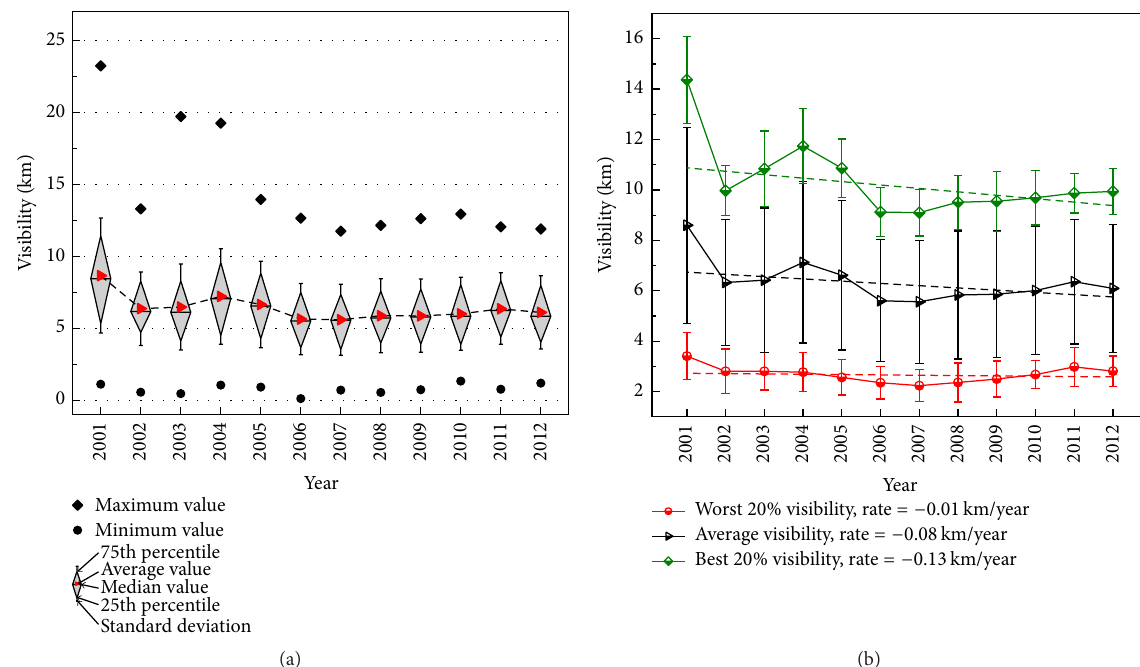
Figure 5: (a) Statistical box chart of long-term trends for the visibility in Hefei during the period from 2001 to 2012. The range of the box represents the interquartile range of the data. (b) The worst 20% and 50% and best 20% region-average visibility trends in Hefei during the period from 2001 to 2012. Dashed lines are the linear regression curves of the corresponding trend lines.